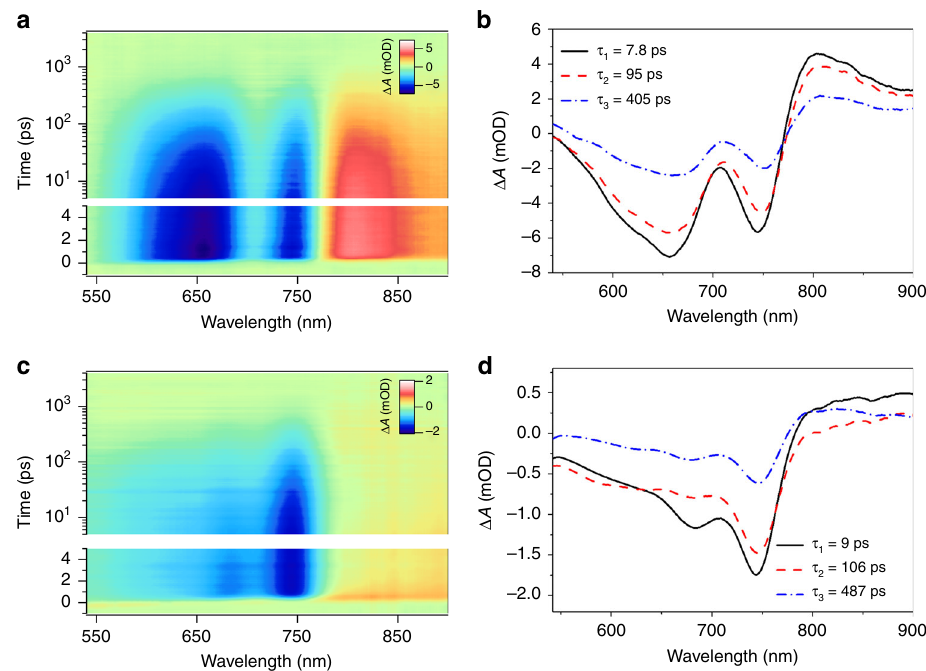
Fig. 6 Transient absorption spectroscopy in aggregate states. a Transient absorption of IIDDT-Me in the DCB fi lm is shown in a pseudo-color plot. b Global analysis of IIDDT-Me in the DCB fi lm. c Transient absorption of IIDDT-Me in the TCE solution is shown in a pseudo-color plot. d Global analysis of IIDDT- Me in the diluted TCE